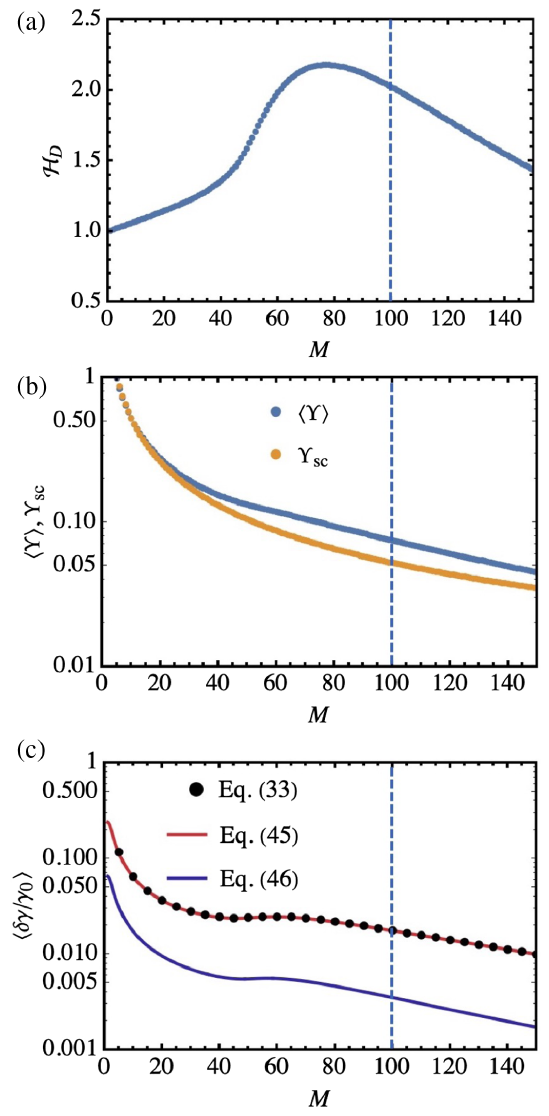
FIG. 4. Computed solutions for (a) luminosity enhancement, (b) beamstrahlung parameter, and (c) fractional energy loss of the entire bunch train for various number of bunches M for the case Ω 2 ¼ 0 . 042 , Θ 2 ¼ 0 . 00027 . Note that the values of Table III correspond to M ¼ 100 on these plots (vertical dashed blue markers). In part (c), numerical solutions of fractional energy loss (black dots) are shown for every fifth M value to aid visualization. Including nonlinearity of the transverse force yields approxi- mately a factor of four reduction in energy loss (blue curve).